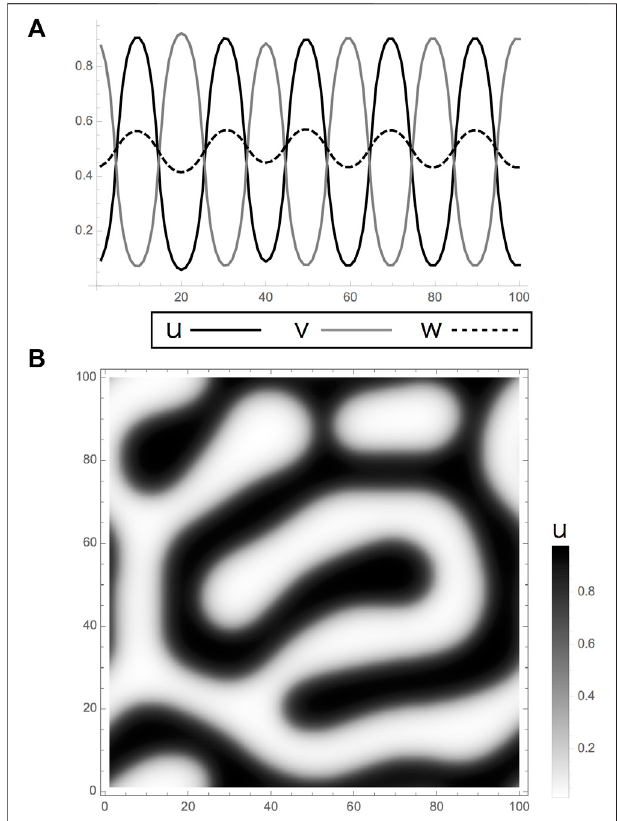
FIGURE2| Turingpatternobtainedbyareaction-diffusionmodelin Eqs 1 , 2 . (A,B). Calculation results of the model had linear terms with limits. (A) One and (B) two dimensions. Results indicate Turing patterns in which the variables u and v are distributed complementarily, and the highly diffusible molecule W peaks at high u